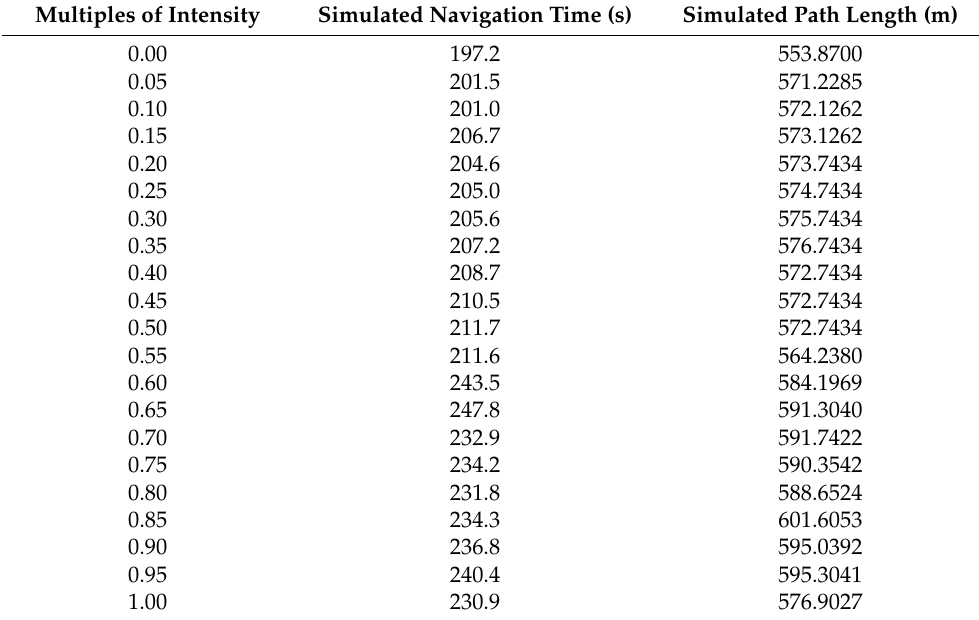
Figure 11. Path length affected by different